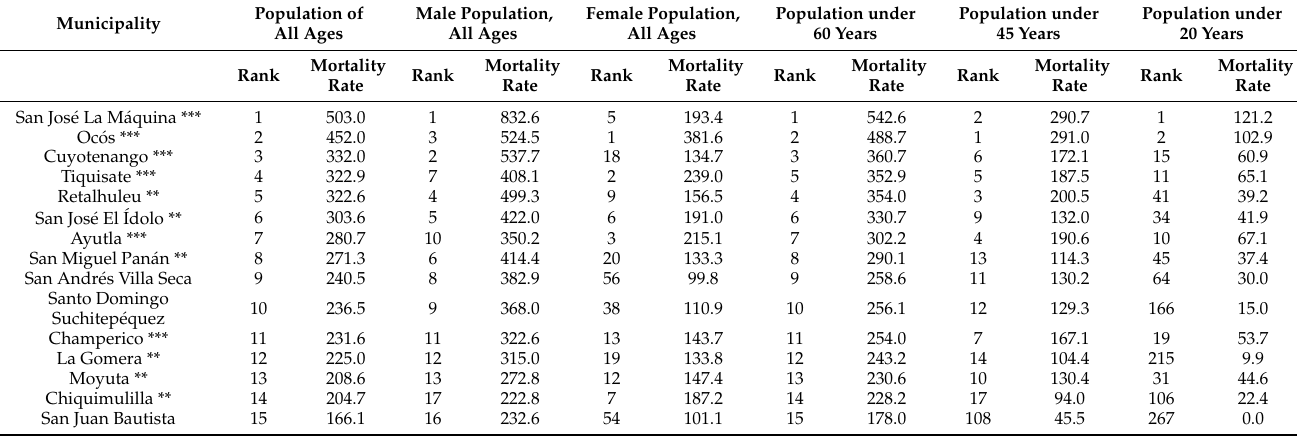
Table 3. Top-15 municipal crude mortality rates for chronic kidney disease, by gender and age group, Guatemala 2009–2019